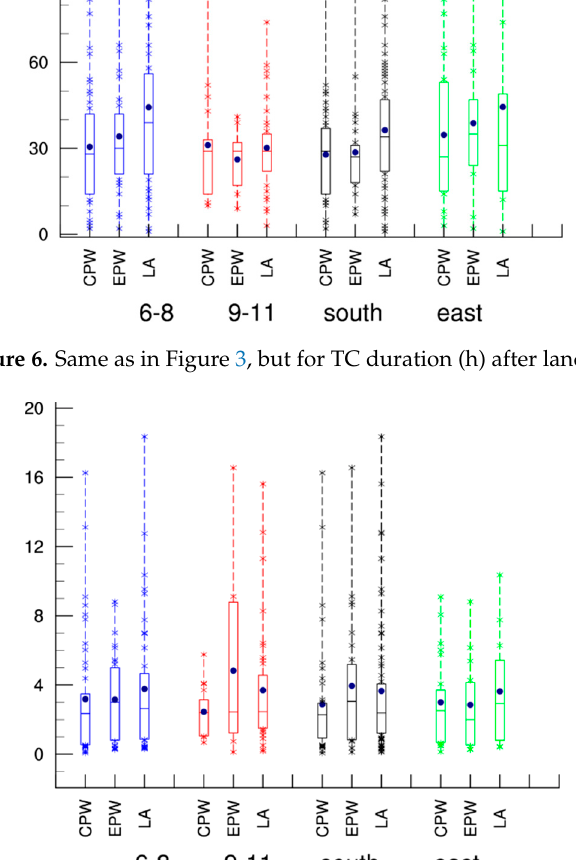
Figure 7. Same as in Figure 3, but for the average PDI (10 5 m 3 /s 3 ) of TCs after landfall.